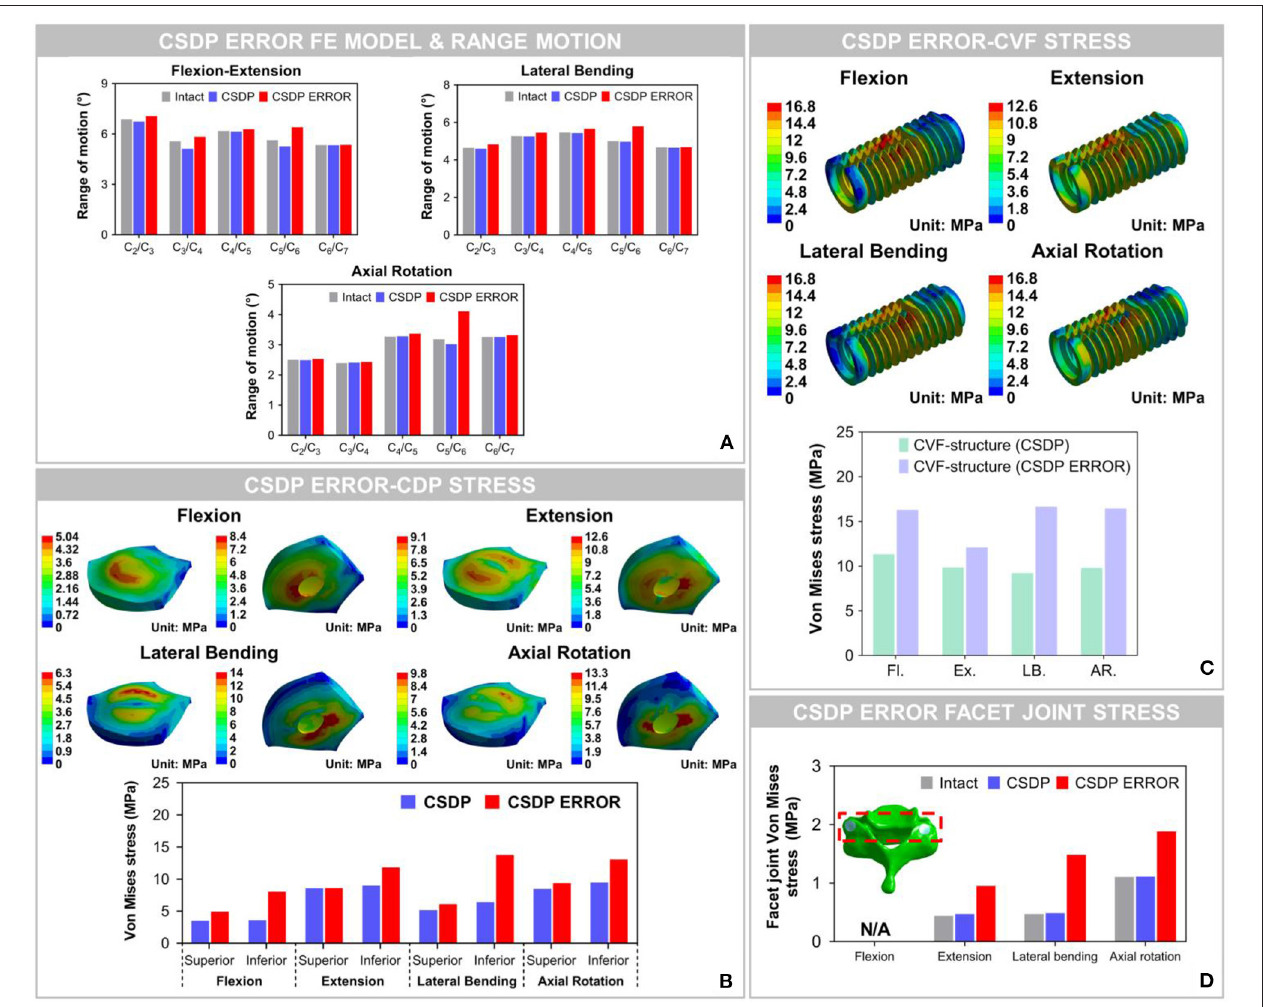
FIGURE 10 | Biomechanical analysis of the cervical subtotal discectomy prosthesis (CSDP) error finite element (FE) model. (A) The results illustrated that range of motion (ROM) increased at the C 5 -C 6 level with CSDP error FE model replacement, and the CSDP error FE model had a greater effect on ROM in axial rotation than in flexion extension and lateral bending. (B) After the CSDP FE model was replaced with the CSDP error model, stress was concentrated in the central region of the CSDP error-CDP-structure FE model. (C) Stress sustained by the CSDP error-CVF-structure FE model was higher than that by the CSDP-CVF-structure FE model, yet still similar to that by the CSDP FE model. (D) Facet joint force within the CSDP error FE model was higher than that in the intact and CSDP FE models. Maximum facet joint force in the CSDP error FE model was observed during axial